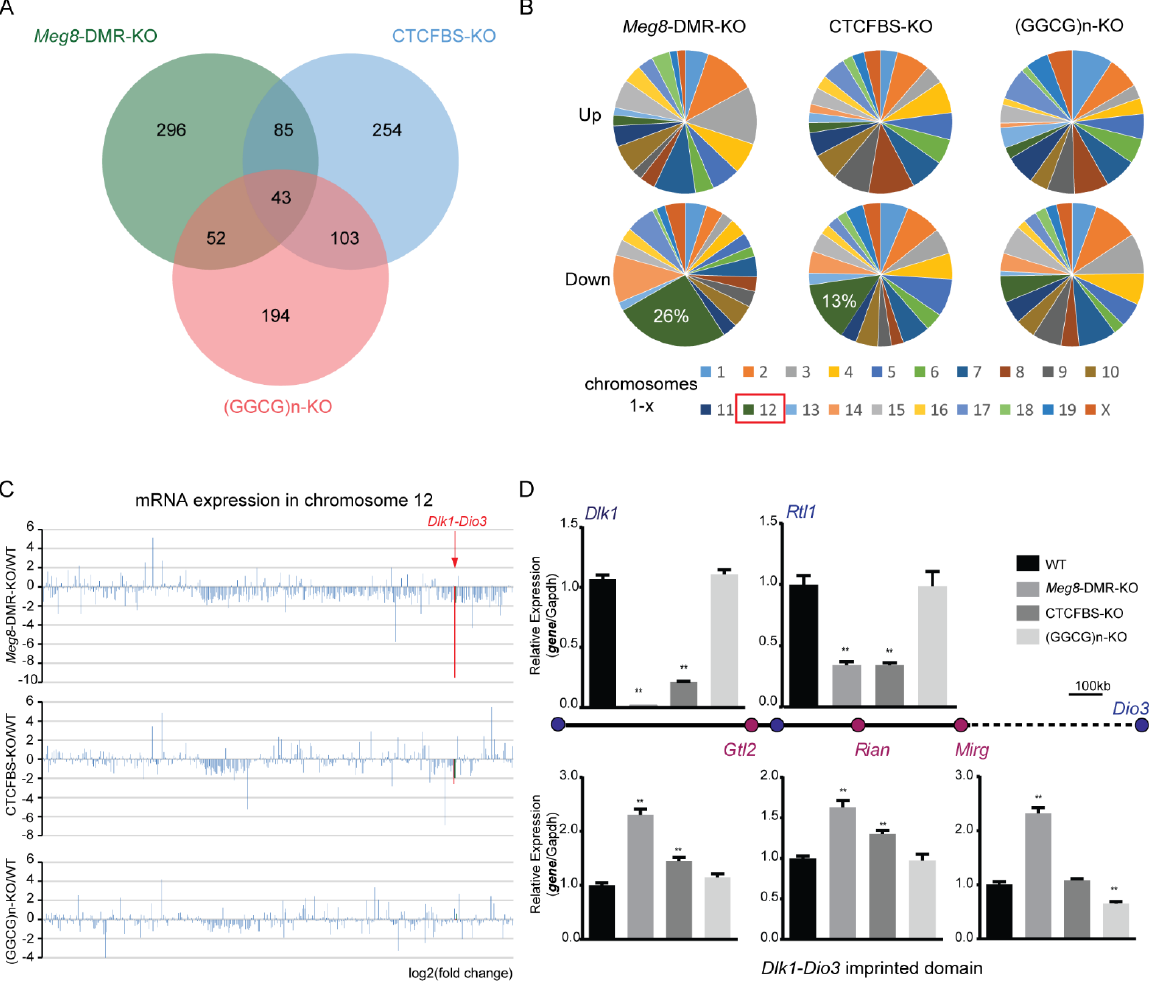
Figure 3. RNA − seq analysis of the Meg8 − DMR deletion cell lines. ( A ) Venn diagram of upregulated genes and downregulated genes in Meg8 -DMR-KO, CTCFBS-KO, and (GGCG)n-KO. ( B ) Distribution of upregulated genes and downregulated genes in Meg8 -DMR-KO, CTCFBS-KO, and (GGCG)n-KO on chromosomes. ( C ) RNA-seq demonstrates log-fold changes of mRNA expression on chromosome 12 in Meg 8-DMR-KO, CTCFBS-KO, and (GGCG)n-KO compared with WT. Significantly reduced expression of Dlk1 and Rtl1 is observed in Meg8 -DMR-KO and CTCFBS-KO. Dlk1 and Rtl1 were marked in red. ( D ) RT-qPCR shows a dramatic reduction in paternal Dlk1 expression and slightly increased expression of maternal Gtl2 , Rian , and Mirg lncRNAs in Meg8 -DMR-KO and CTCFBS-KO compared with WT. Strand-specific RT-PCR shows a dramatic reduction in paternal Rtl1 expression in Meg8 -DMR-KO and CTCFBS-KO compared with WT. The relative expression level was normalized by Gapdh . Error bars, mean ± SEM. n ≥ 3. p values were calculated using t -test. ** p <